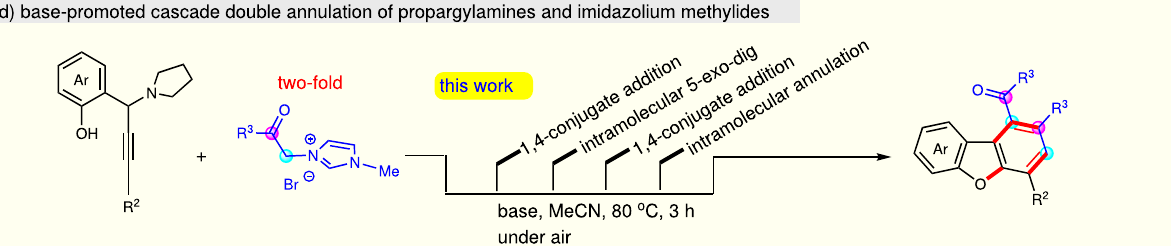
Fig. 1 Modern approaches for accessing dibenzofuran skeletons. A brief glance of modern synthetic methods for preparing multiple arene-substituted dibenzofurans. a Recent examples of intramolecular cyclization of non-substituted or ortho -substituted aryloxybenzenes in constructing dibenzofuran framework under transition metals catalyst systems. b Intramolecular O -arylation of ortho -arylphenols for making dibenzofuran skeleton. c Direct electrophilic functionalization of dibenzofuran molecules. d A cascade reaction between propargylic amine and imidazolium methylide to access dibenzofuran skeletons (this